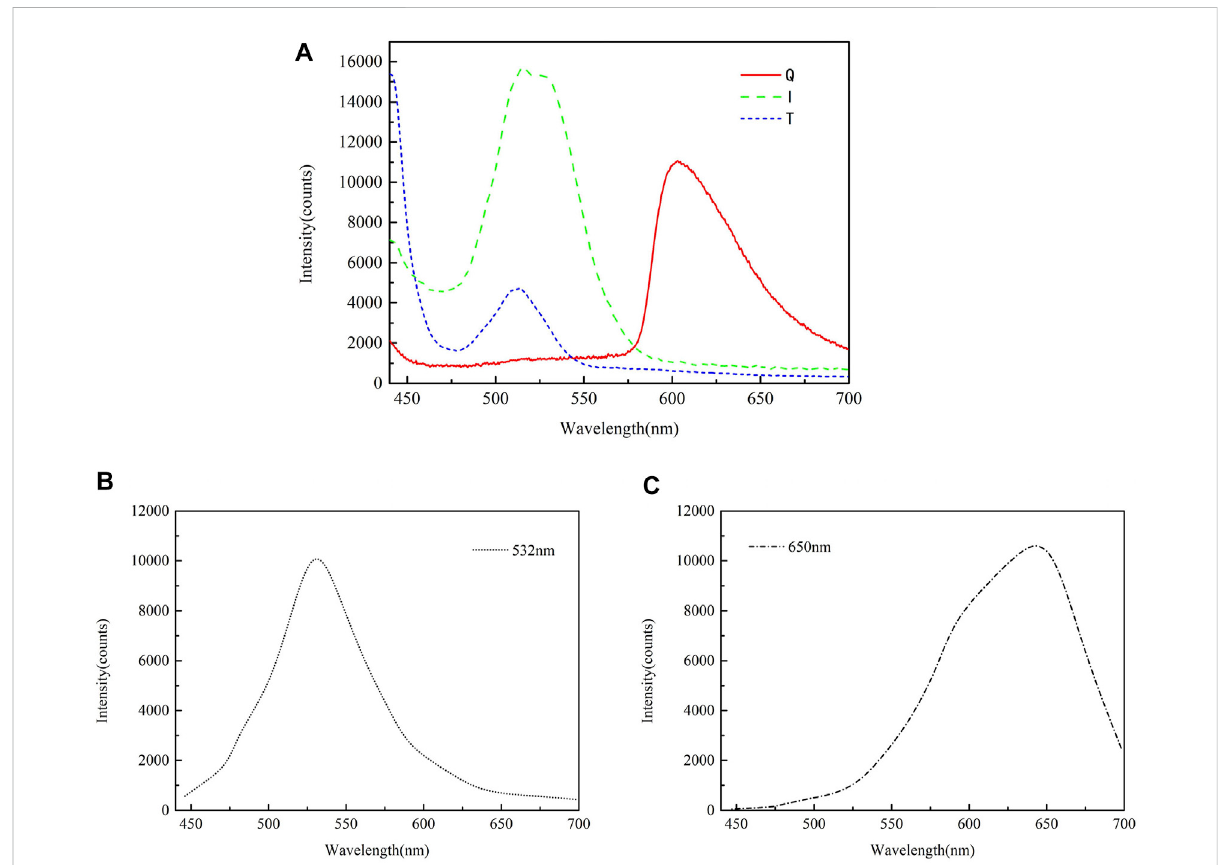
FIGURE 5 Spectral distribution of USB4000-VIS-NIR spectrometer and color targets in multispectral images. (A) The spectral distribution curve of letter QIT in the test target of USB4000-VIS-NIR spectrometer (B) The spectral distribution curve of the letter “ I ″ in the reconstructed image of the target object irradiated by 532 nm laser (C) The spectral distribution curve of the letter “ Q ” in the reconstructed image of the target object irradiated by 650 nm